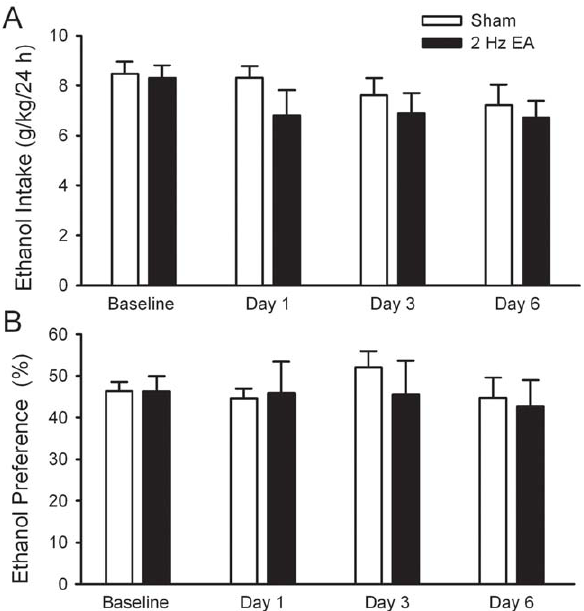
Figure 3. Multiple sessions of low frequency (2 Hz) EA did not alter the excessive intake of and preference for ethanol. EA at low frequency (2 Hz) or sham were administered to rats for 6 consecutive days 10 min before the start of ethanol- or water- drinking session. The effect was measured on day 1, 3, and 6. The values are expressed as mean 6 SEM. n=8 animals in each